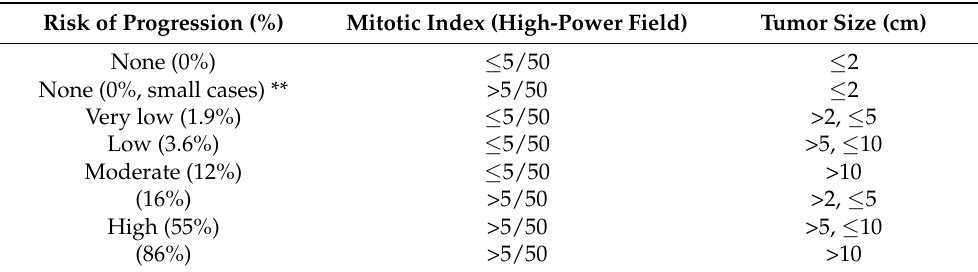
Table 1. Risk stratification of gastric gastrointestinal stromal tumors (GISTs) (risk for progressive disease) † .